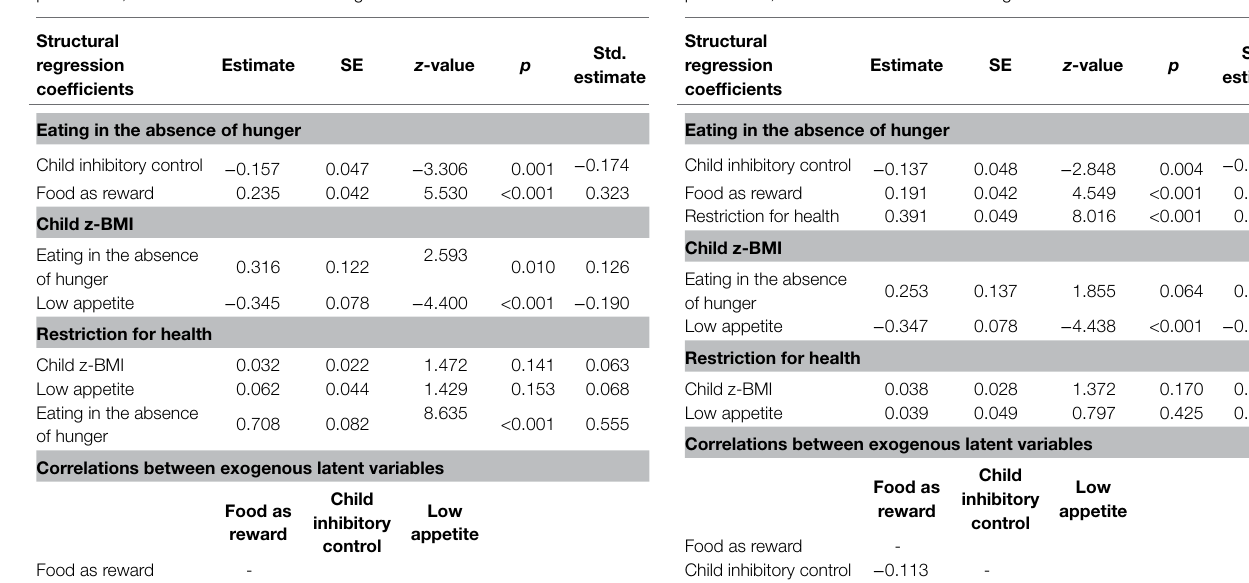
TABLE 6 | SEM model 2A: parameter estimates, SE, z -values, value of p , and standardized estimates (i.e., completely standardized solutions) for regression parameters, and correlations between exogenous latent variables.